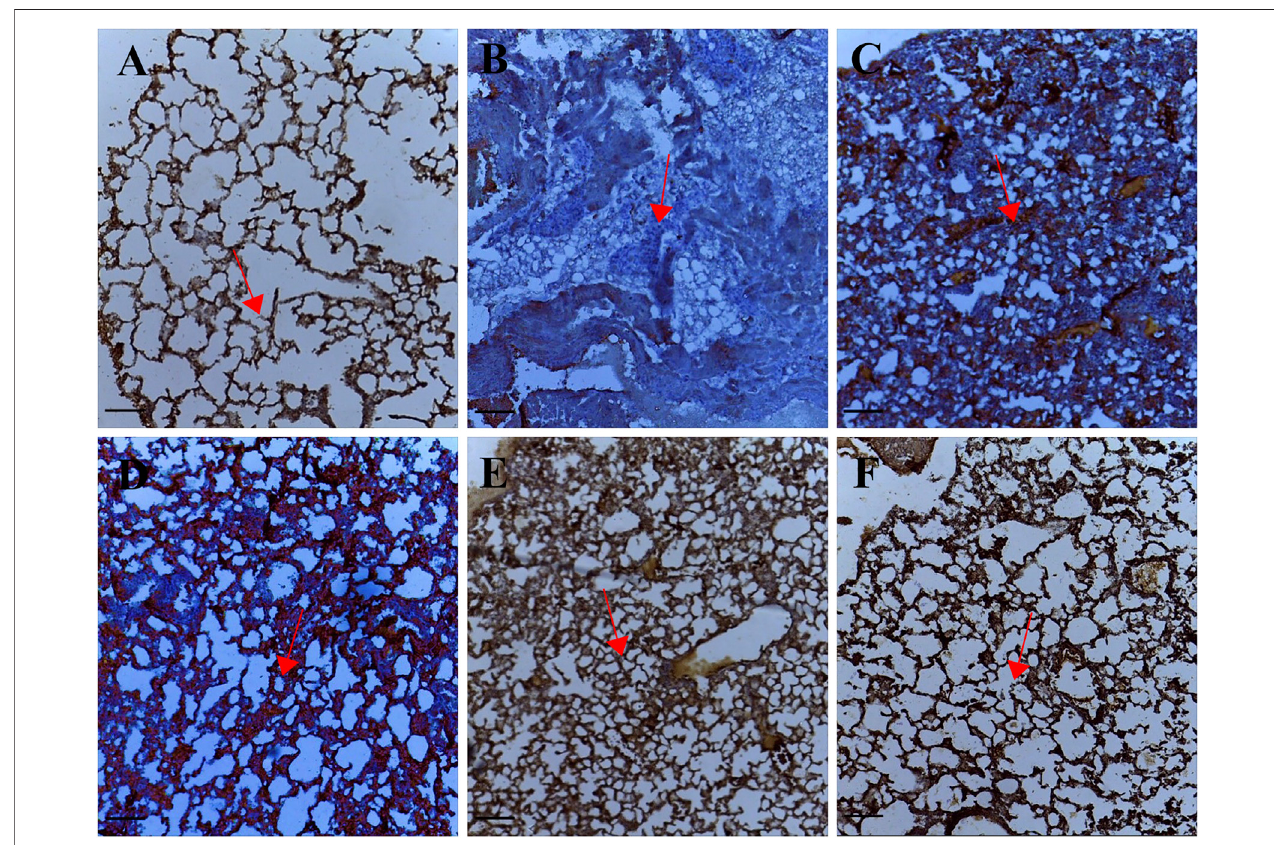
FIGURE 4 | Representative photomicrographs of p53 expression in IHC sections of the lung tissue: (A) Normal saline (B) Lung metastasis (C – E) Palmatine 1 – 10 mg/kg (F) Doxorubicin5 mg/kg.Datawereobtainedfrom fi ve fi eldsperslidewithsevenslidesanalyzedfromeachgroup.Redarrowsshowimmunoreactiveareas. Scale bar 20 mm (×10, (A – F)